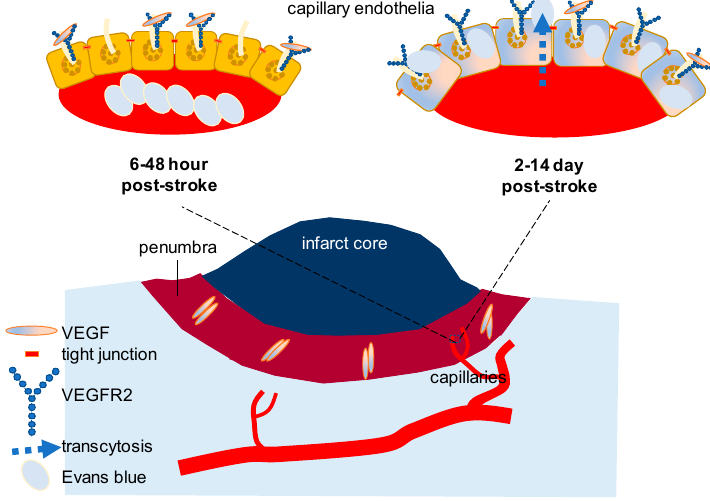
Figure 1. VEGF signaling in blood brain barrier (BBB) breakdown after stroke: after ischemic stroke,